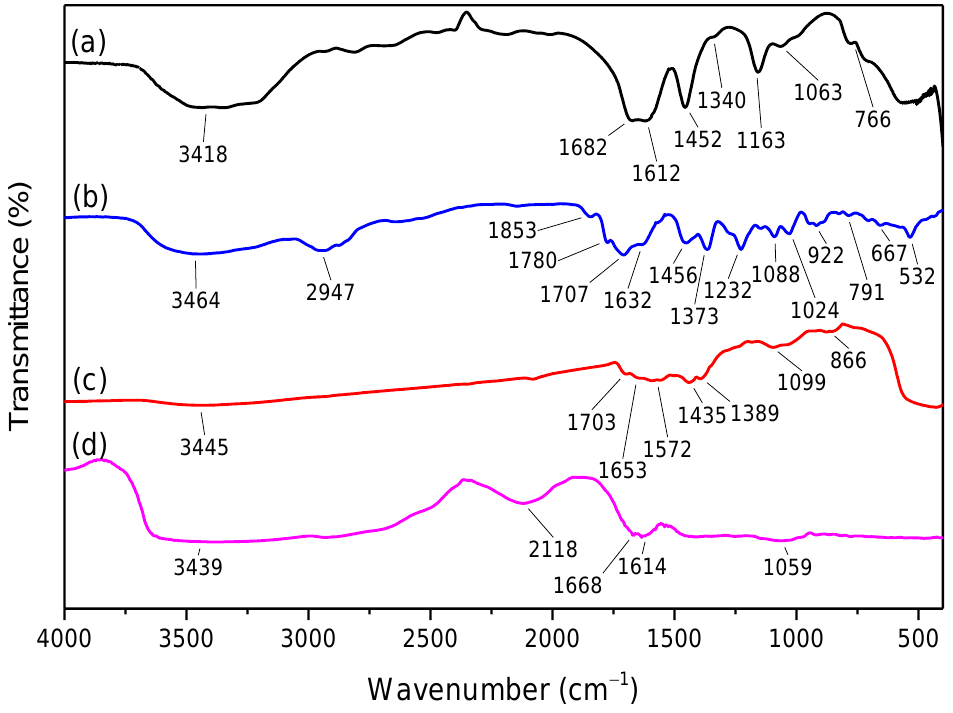
Figure 7. IR spectra: ( a ) urea, ( b ) ash, ( c ) gelatin, ( d ) A/UG film at urea/gelatin ratio 1:1 and ash/gelatin ratio 2:1 over time of 60 min.